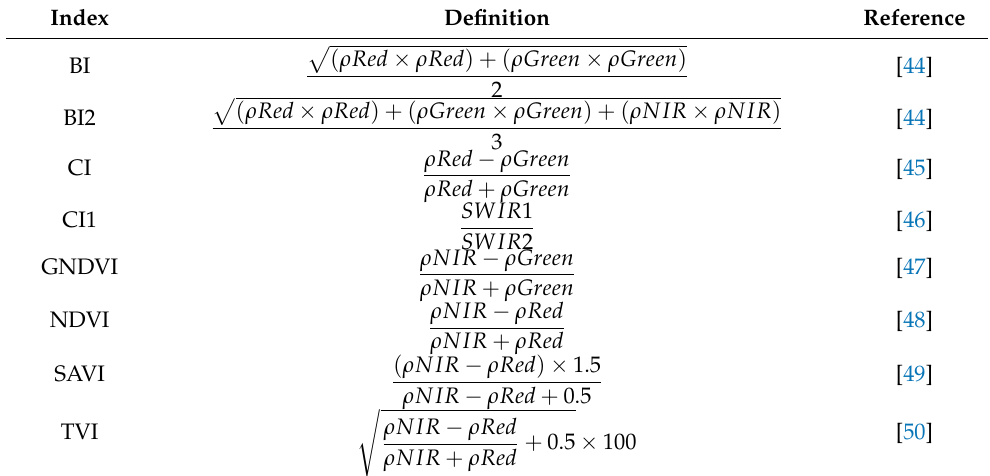
Table 1. Derived indices.